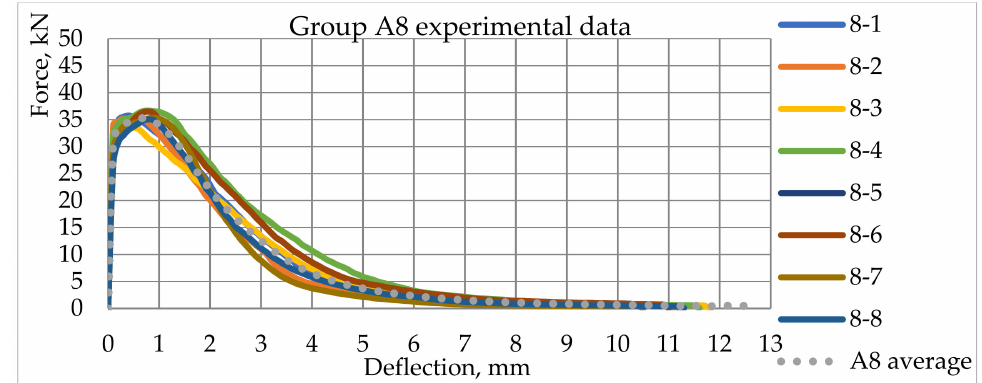
Figure 22. Load—sample center vertical deflection graphs for the specimens in Group A8.